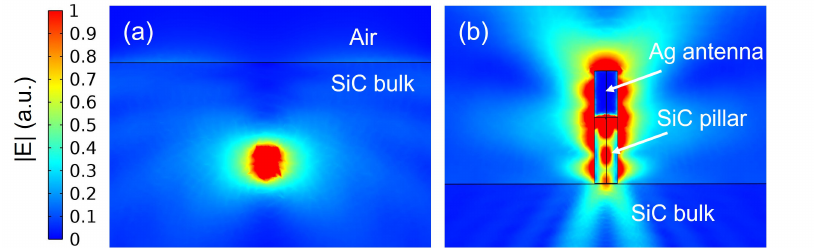
Figure 6. The 2-D normalised electric field pattern for a point dipole emission in ( a ) bulk SiC and ( b ) coupled SiC pillar/Ag antenna scheme optimized at 917